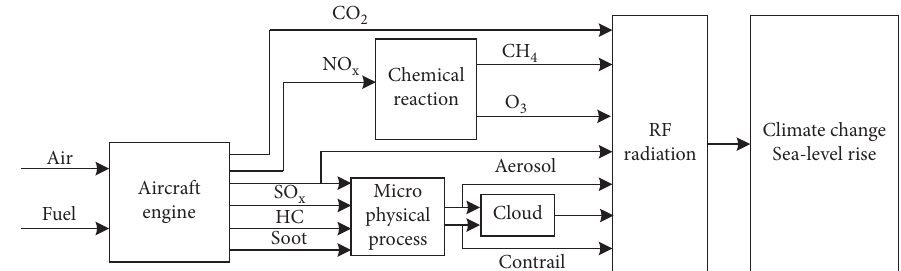
Figure 3: Mechanism of the influence of engine emissions on the